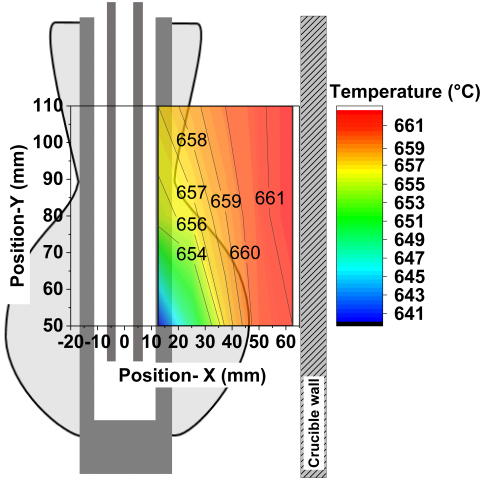
Figure 6. Combined temperature profile based on the vertical- and horizontal measurements of temperature, applying software